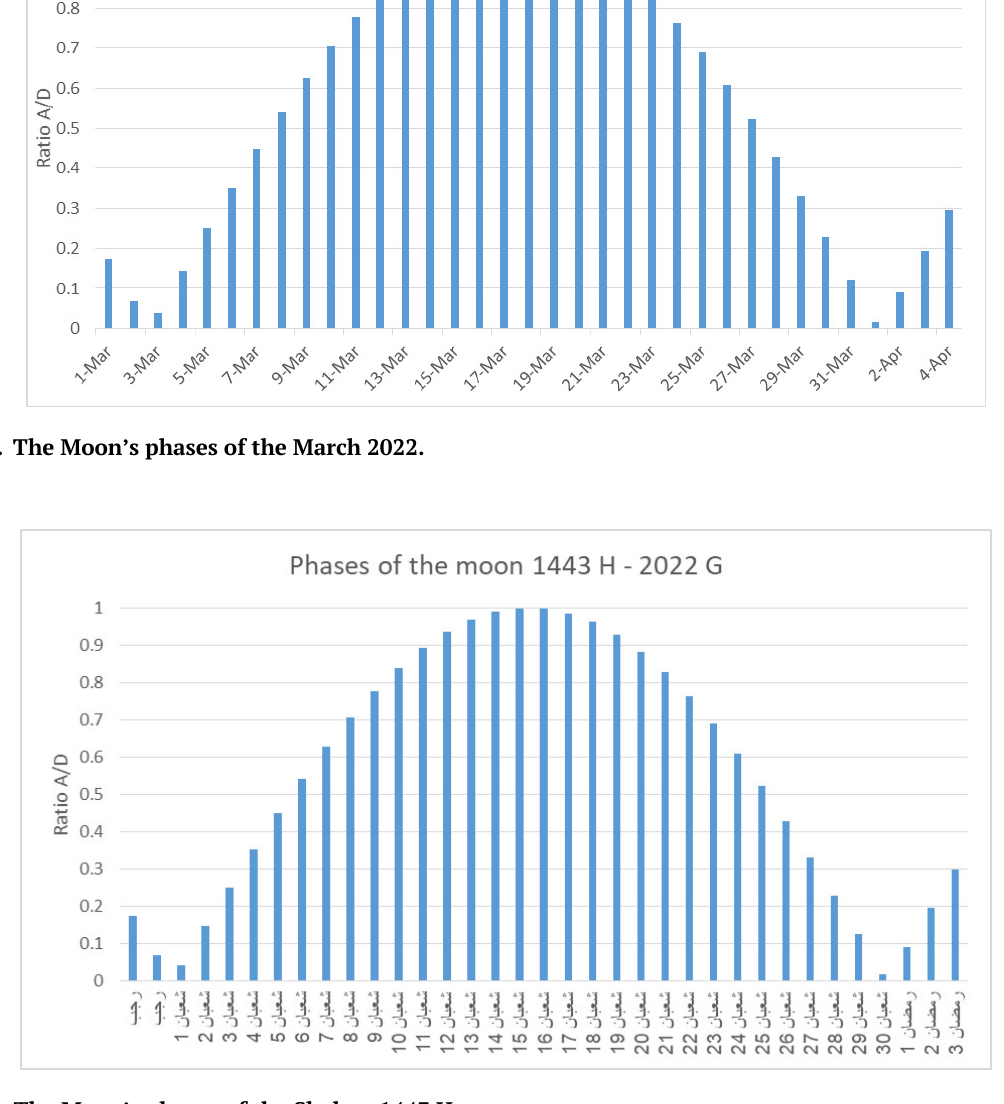
Figure 3b. The Moon’s phases of the Shaban 1443 H.